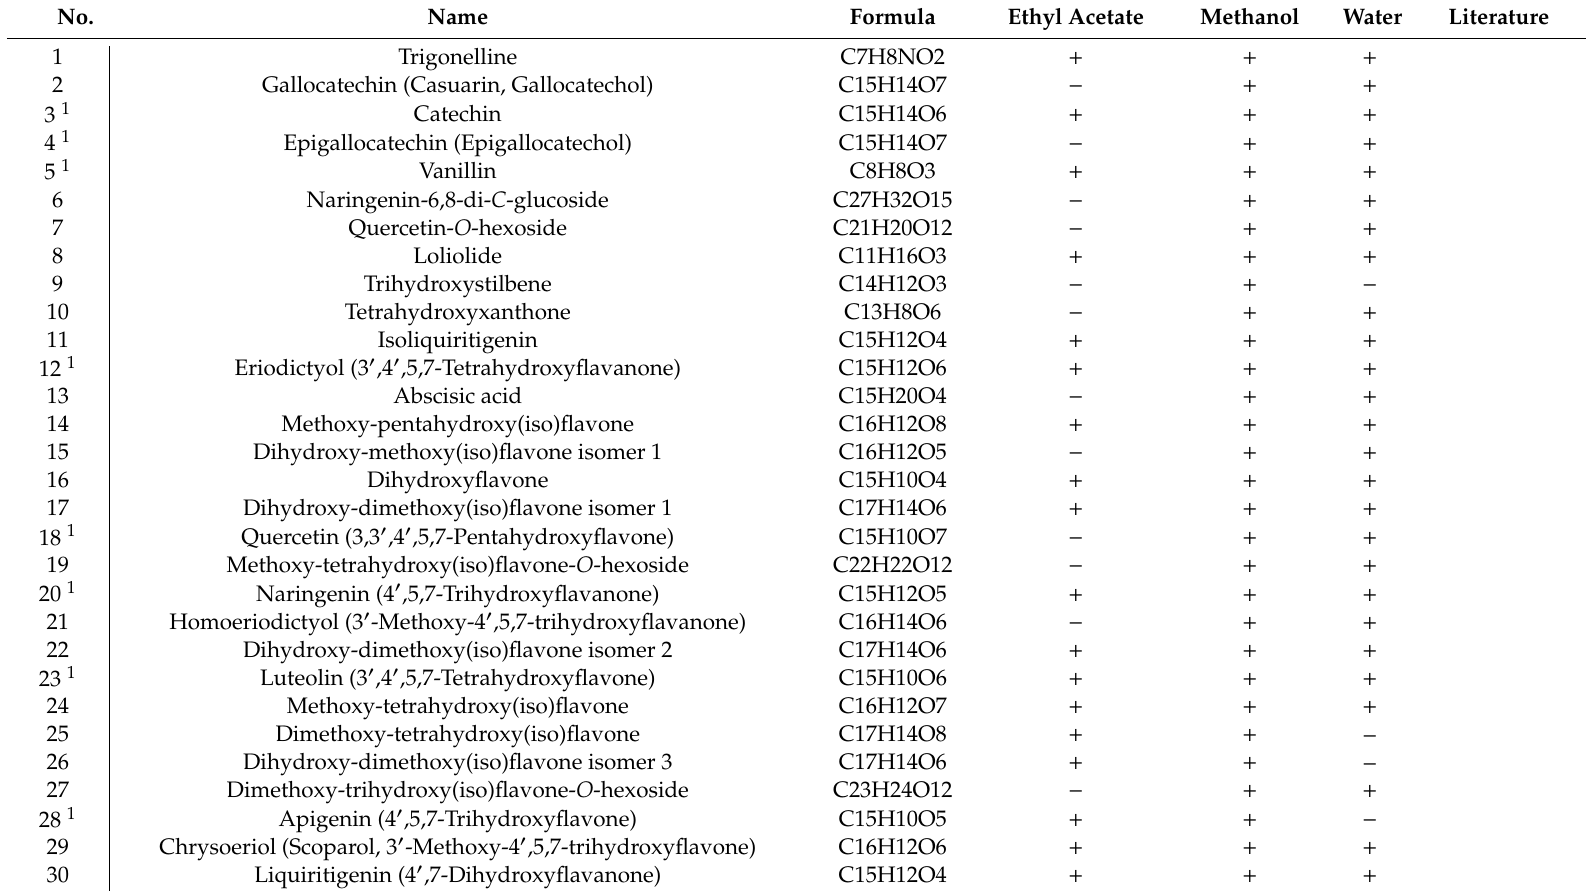
Table 2. Chemical composition of the tested